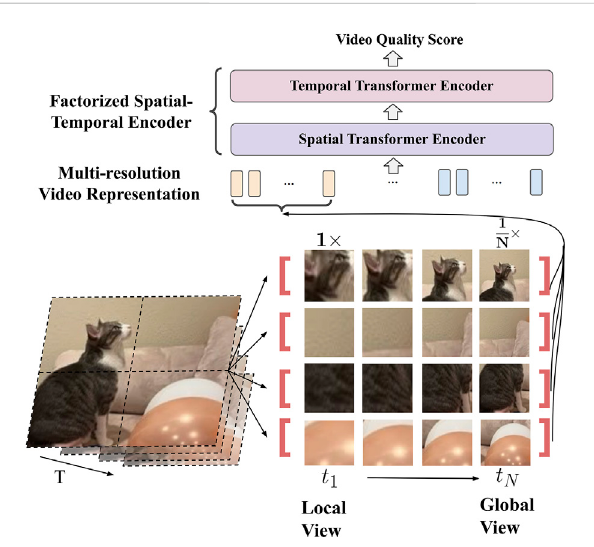
FIGURE 2 The proposed multi-resolution Transformer (MRET) for VQA. To capture both global composition and local details of video quality, we build a multi-scale video representation with patches sampled from proportionally resized frames with different